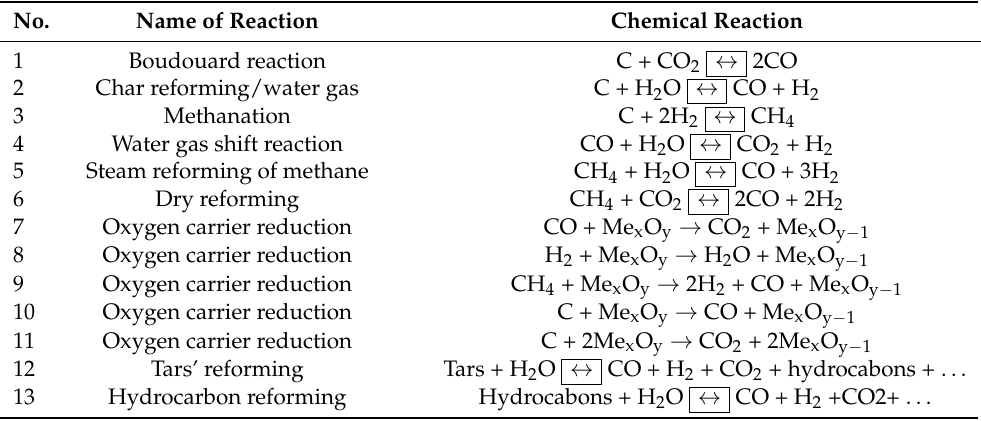
Table 1. Chemical reactions in fuel reactor [19,21,22].